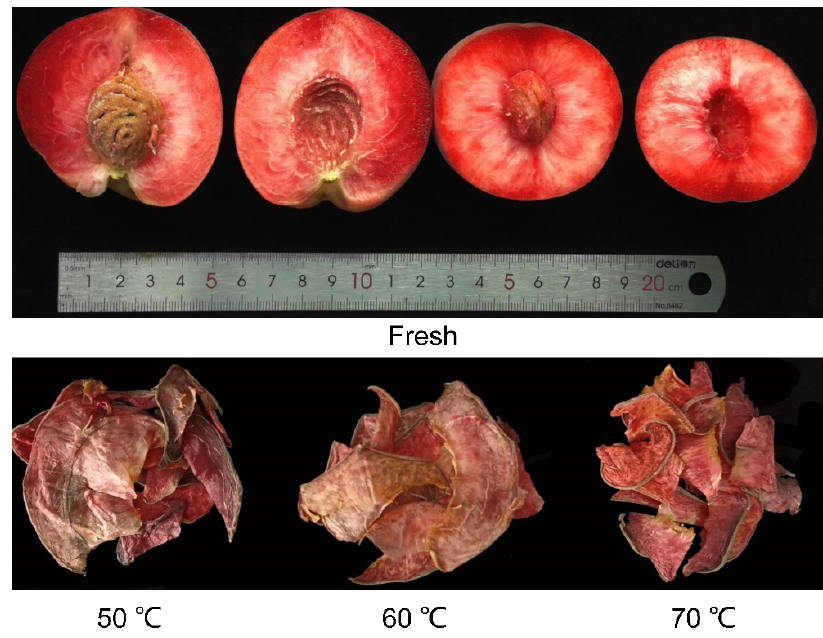
Figure 3. Fresh blood-flesh peach and dried samples under HAD at 50 °C, 60 °C, and 70 °C.